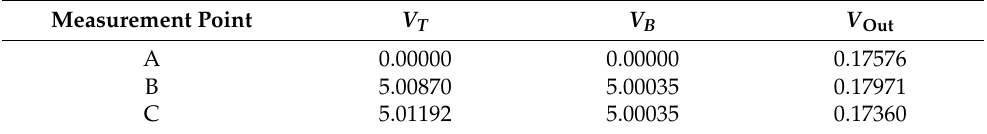
Table 2. Measurement data of sample #1.